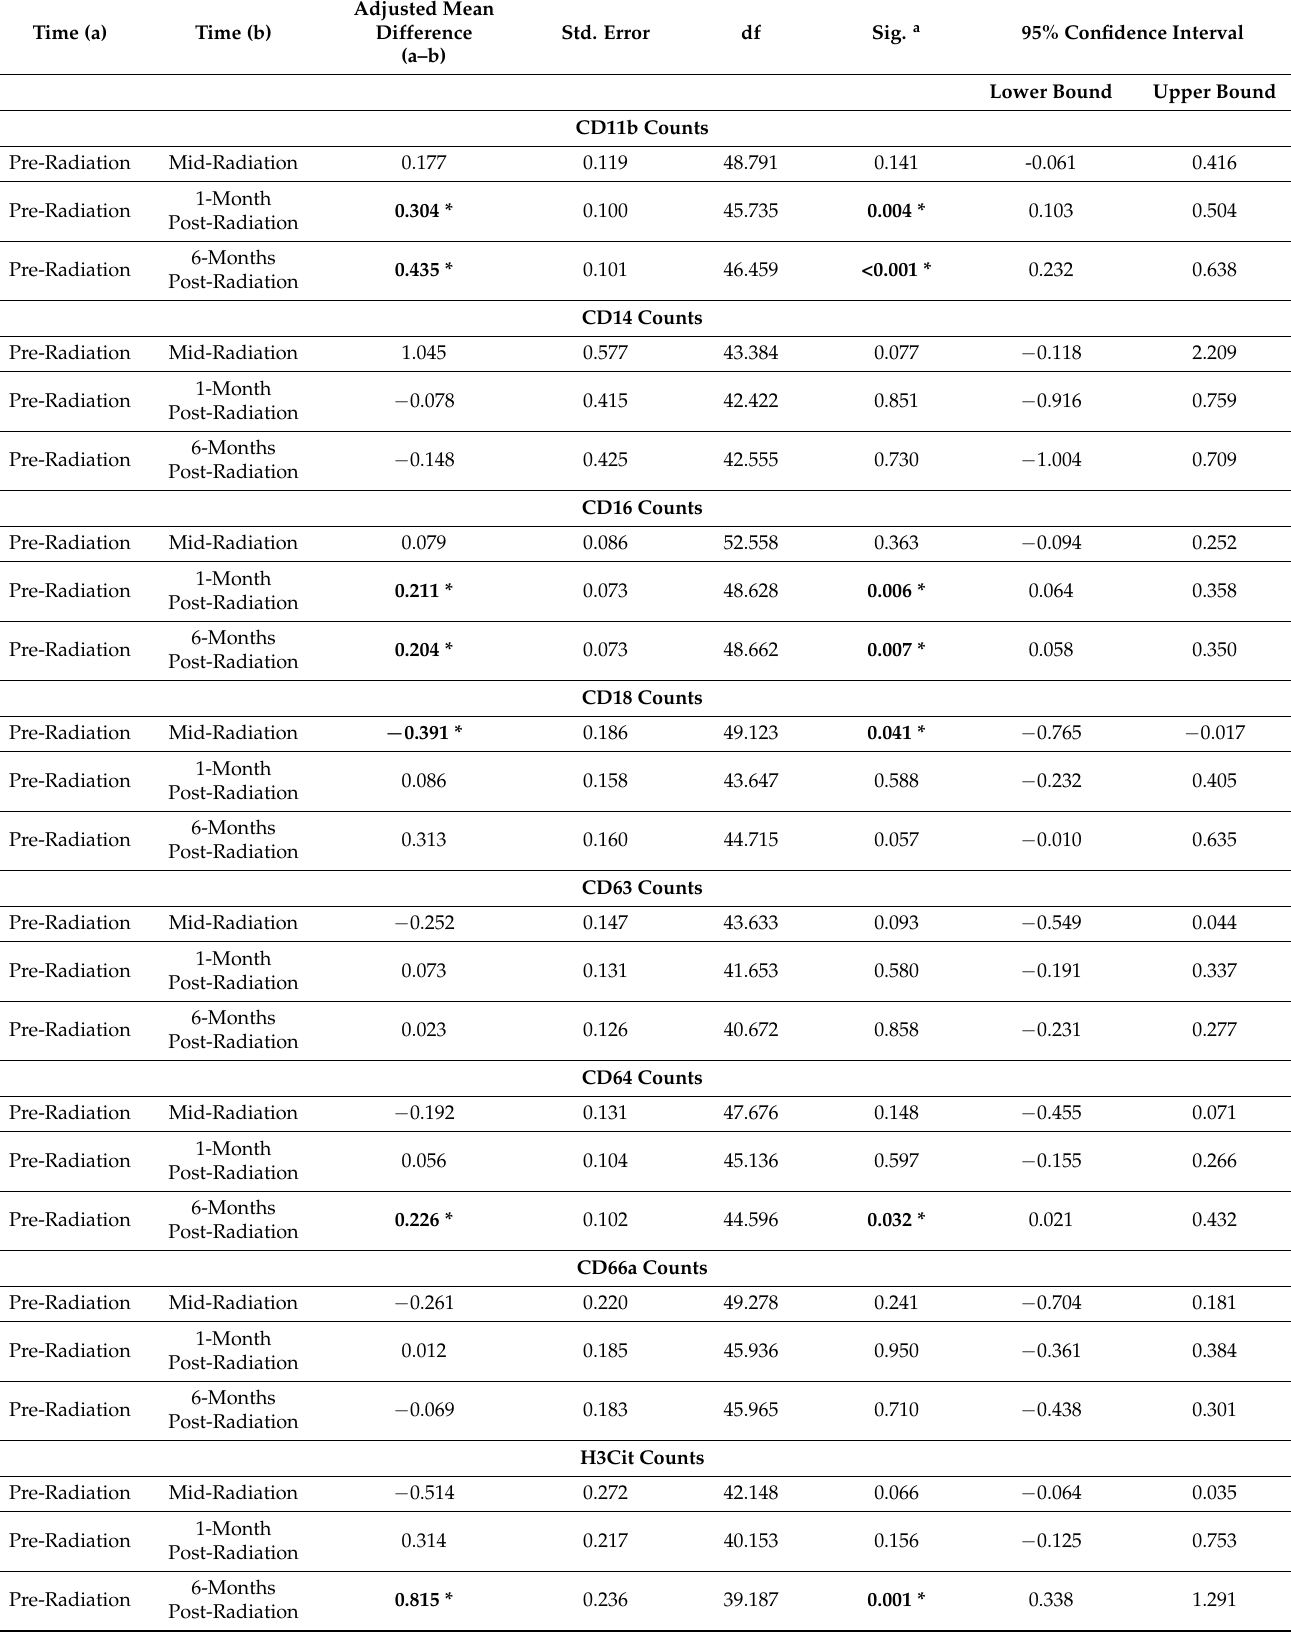
Table A11. Pairwise comparisons of the mean difference in the oPMN marker